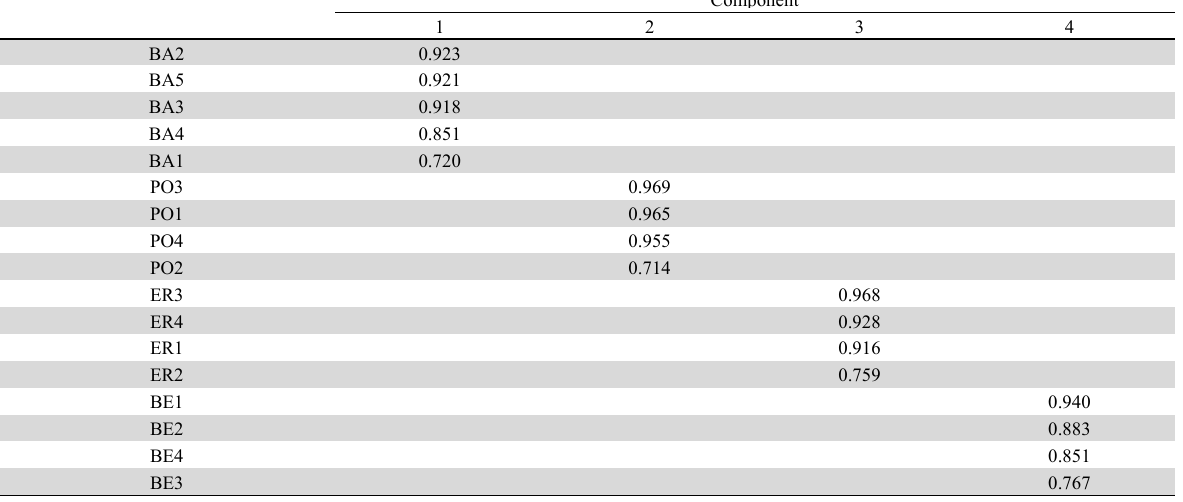
Rotated Component Matrix for independent variables